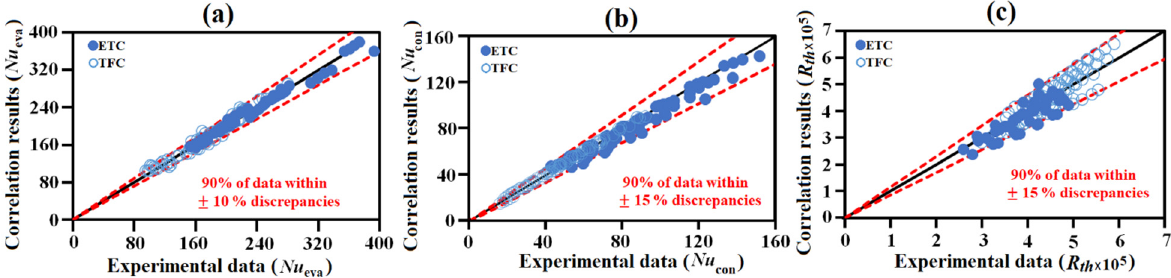
Figure 10. Comparisons of experimental data and correlative results for ( a ) Nu eva ( b ) Nu con ( c ) R th .